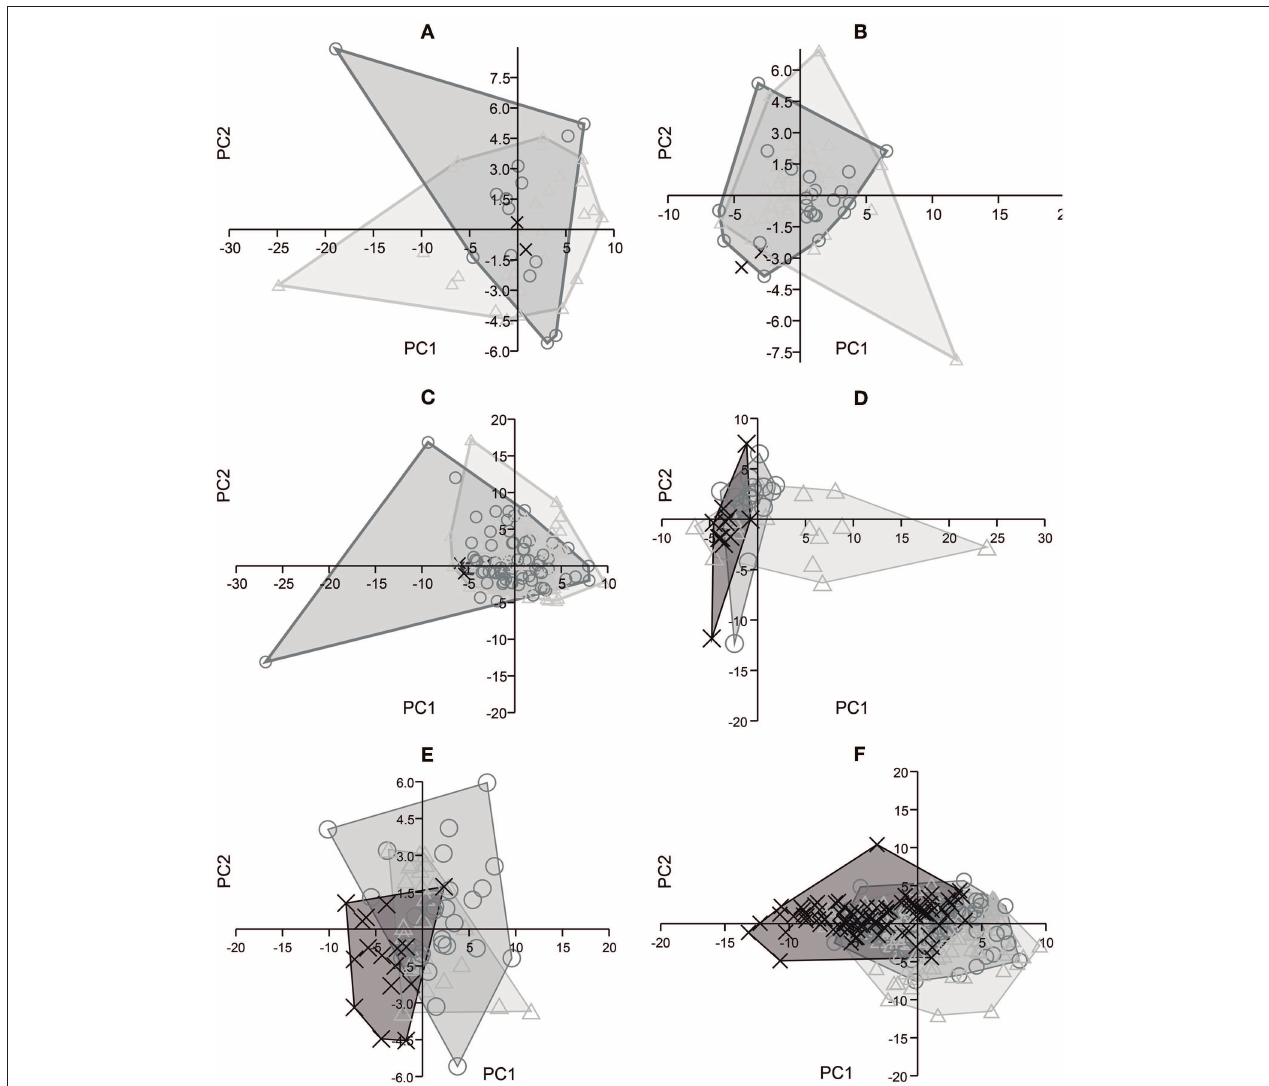
FIGURE 4 | Principal component analysis based on three dimensions of upper cheek teeth and five dimensions of lower cheek teeth of E. neogeus (circle), E. insulatus (triangle), and E. andium (x). Projected scores on: (A) Principal Components 1 (74%) and 2 (18%) from the analysis of P2; (B) Principal Components 1 (59%) and 2 (29%) from the analysis of M3; (C) Principal Components 1 (47%) and 2 (41%) from the analysis of P3, P4, M1, and M2; (D) Principal Components 1 (57%) and 2 (31%) from the analysis of p2; (E) Principal Components 1 (67%) and 2 (20%) from the analysis of m3; and (F) Principal Components 1 (61%) and 2 (25%) from the analysis of p3, p4, m1, and